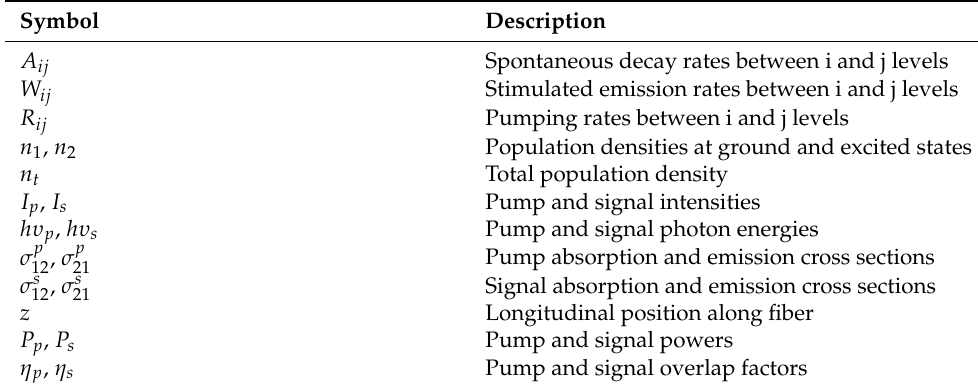
Table 1. Different symbols used in Equations (1)–(8).